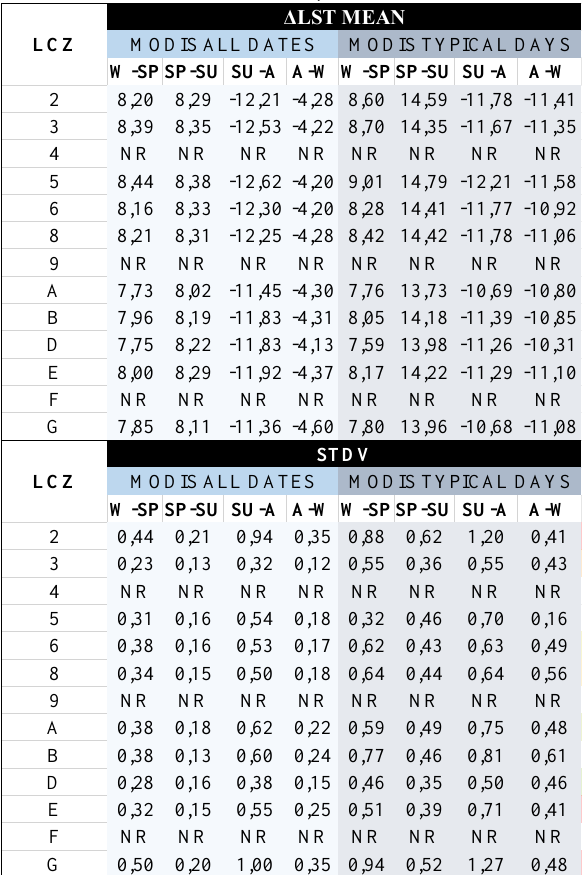
Table 4 . Mean LST variations between seasons per LCZ and the standard deviation. NR= non representative